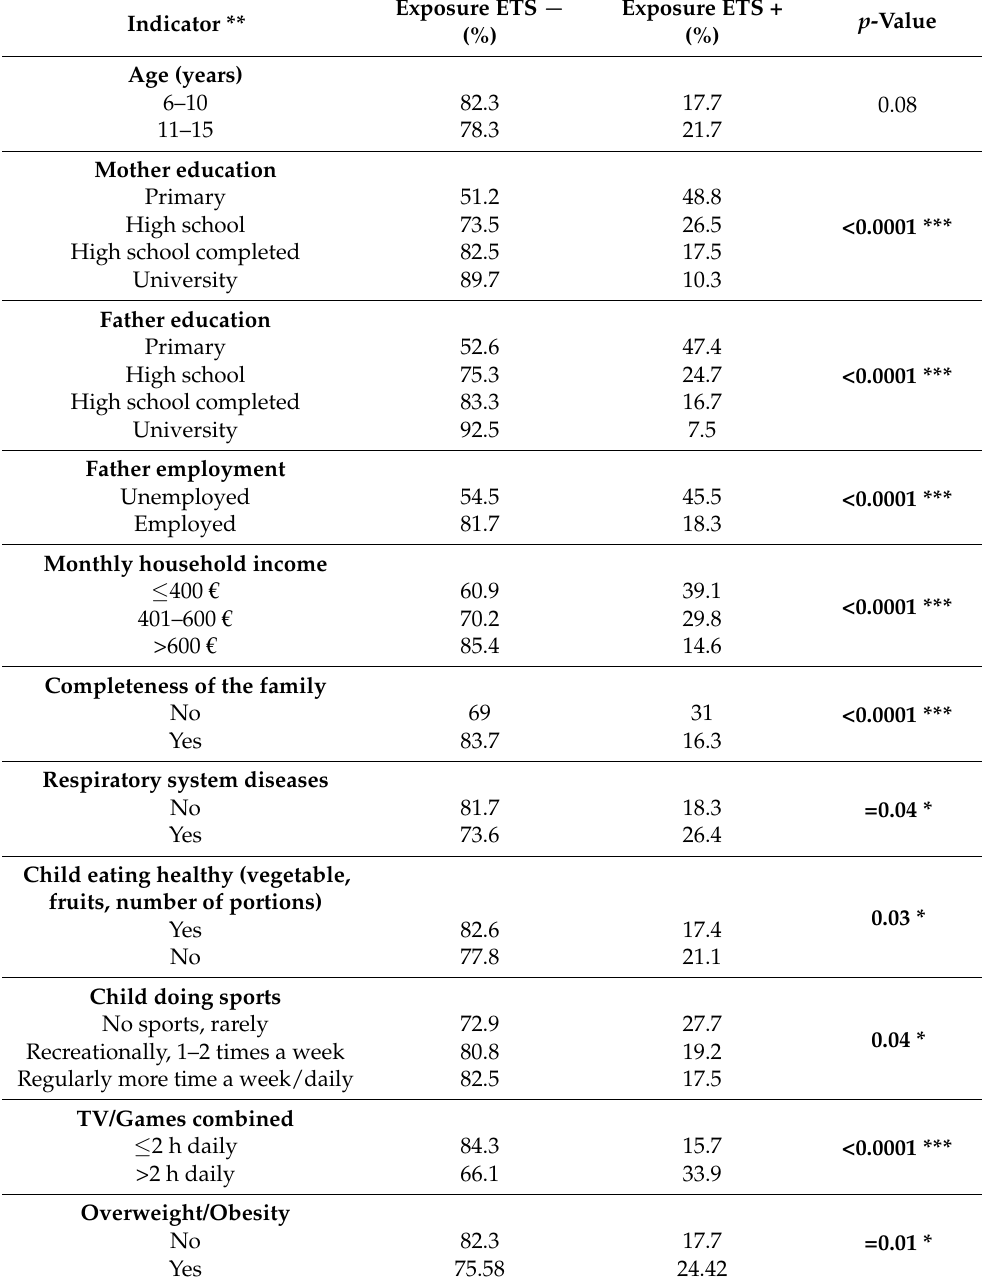
Table 2. Relations between selected indicators and children’s exposure to ETS ( n = 1373)